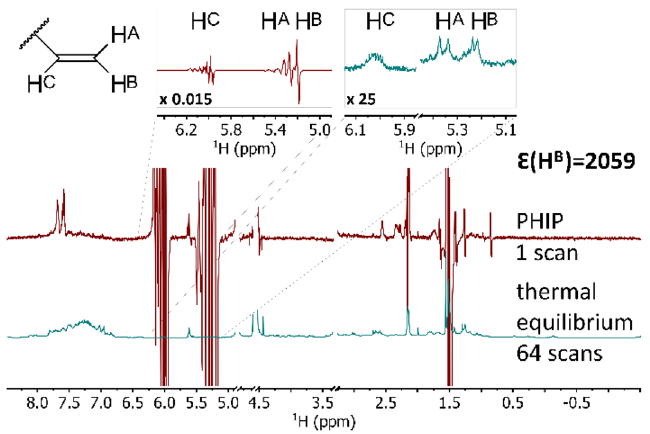
Figure 3. 1 H-NMR spectra of 1 mM hydrogenated OctF1PrgAlc ( 1-A1 ) in MeOD-d 4 with 1.96 mM catalyst at 25 °C and 500 MHz (11.7 T). The upper spectrum in red is the PHIP spectrum after 25 s of reaction time, acquired in a single scan with a receiver gain of 3.9. The lower one in blue is the spectrum at thermal equilibrium after the relaxation of the hyperpolarization, acquired with 64 scans and a receiver gain of 287. The inserts (on the top) show a magnification of the signals of the allyl moiety. The hyperpolarized signals below 2.5 ppm correspond to the activated catalyst. The structure of the allyl moiety, which is a part of the reaction product of the PHIP marker, is presented on the top left. Hydrogens H B and H C originate from the parahydrogen molecule. The signals of H A and H B can be easily distinguished by their dipolar coupling constants to H C53 . The greatest SE factor Ɛ of 2059 is obtained for the signal of hydrogen H B . The signals of the solvent, molecular hydrogen and a catalyst signal in the insert of the thermal spectrum have been removed for clarity of presentation.